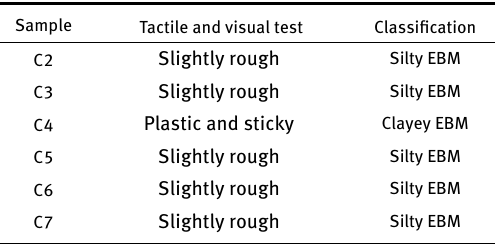
Table 1: Tactile and visual test results.